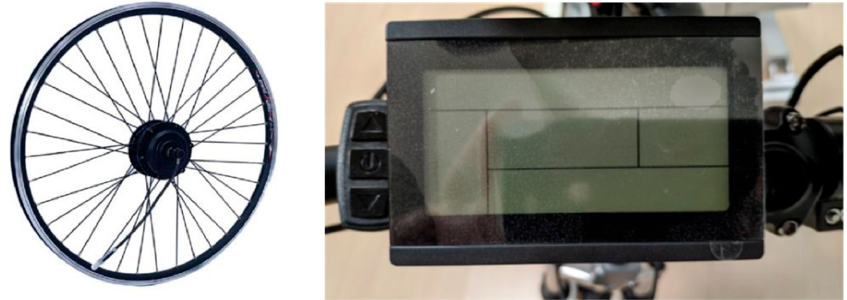
Figure 5. Motorized wheel (on the left); display and motor start button integrated in the wheel (on the